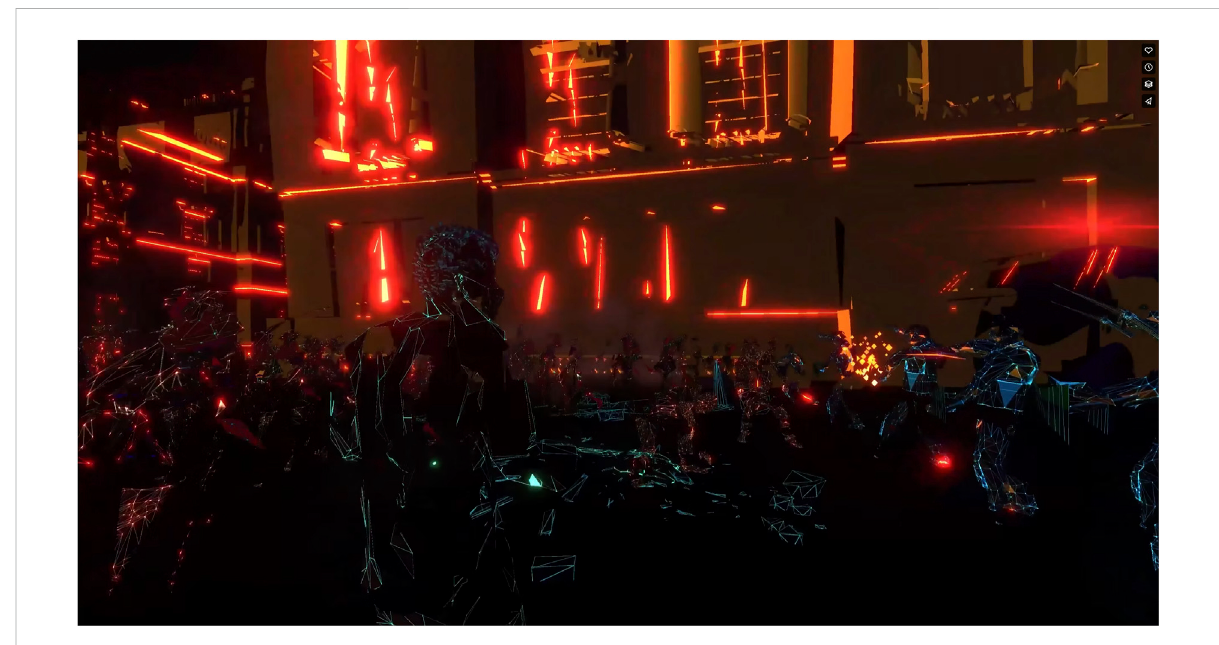
FIGURE 2 Screen capture of riot sequence as shown in trailer video of “ Stress Management and Civil Unrest ” VR experience by Head Set. Video available from